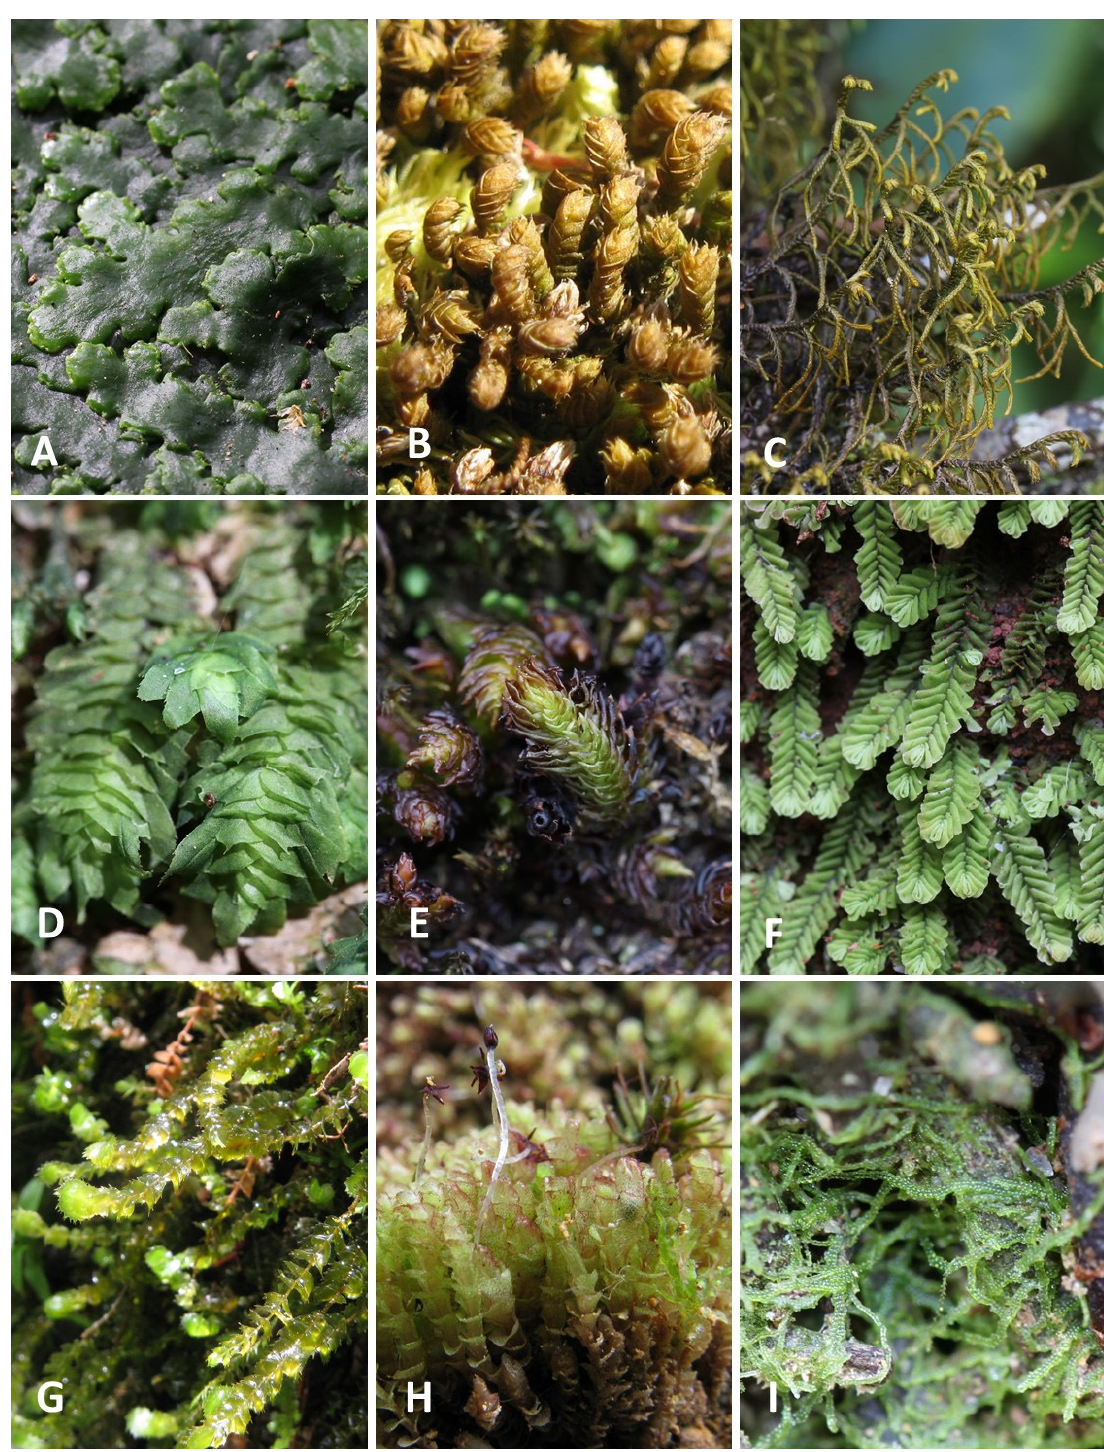
Figure 4. Some liverworts in Cambodia. ( A ) Lobatiriccardia coronopus ; ( B ) Anastrophyllum piligerum ; ( C ) Mastigophora diclados ; ( D ) Schistochila aligera ; ( E ) Pleurozia gigantea ; ( F ) Plectocolea comata ; ( G ) Plagiochilion oppositum ; ( H ) Plectocolea ariadne ; ( I ) Zoopsis liukiuensis . (Photo by S.S. Choi, 2009–2013).